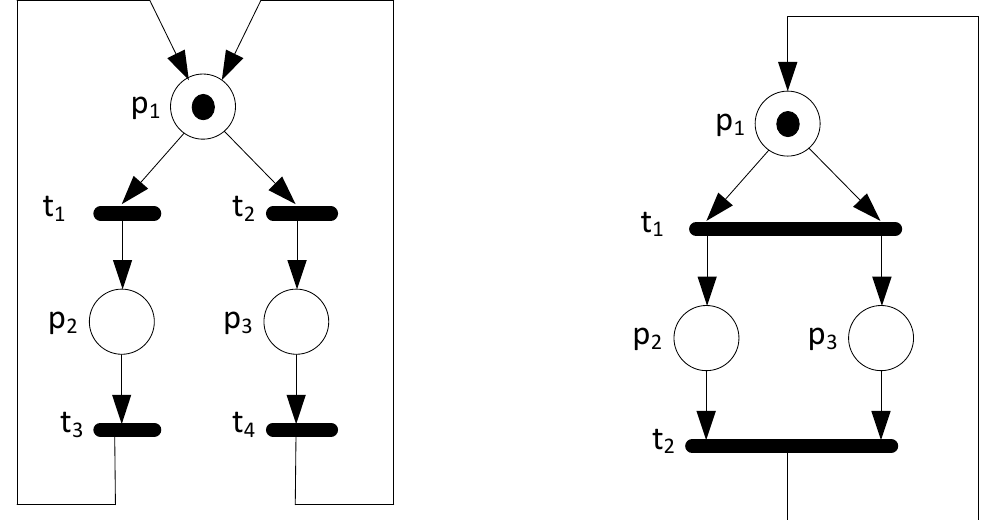
Figure 8. Exemplary live and bounded Petri nets: sequential ( left ) and concurrent ( right ).